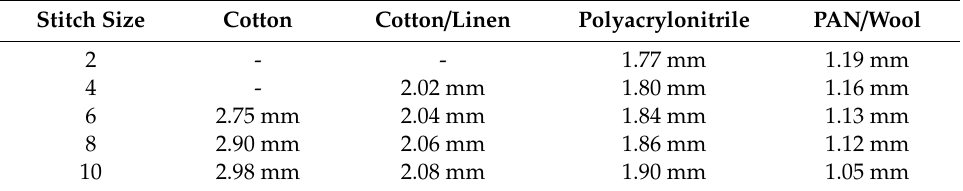
Table 1. Thicknesses of knitted fabrics under examination in this study.